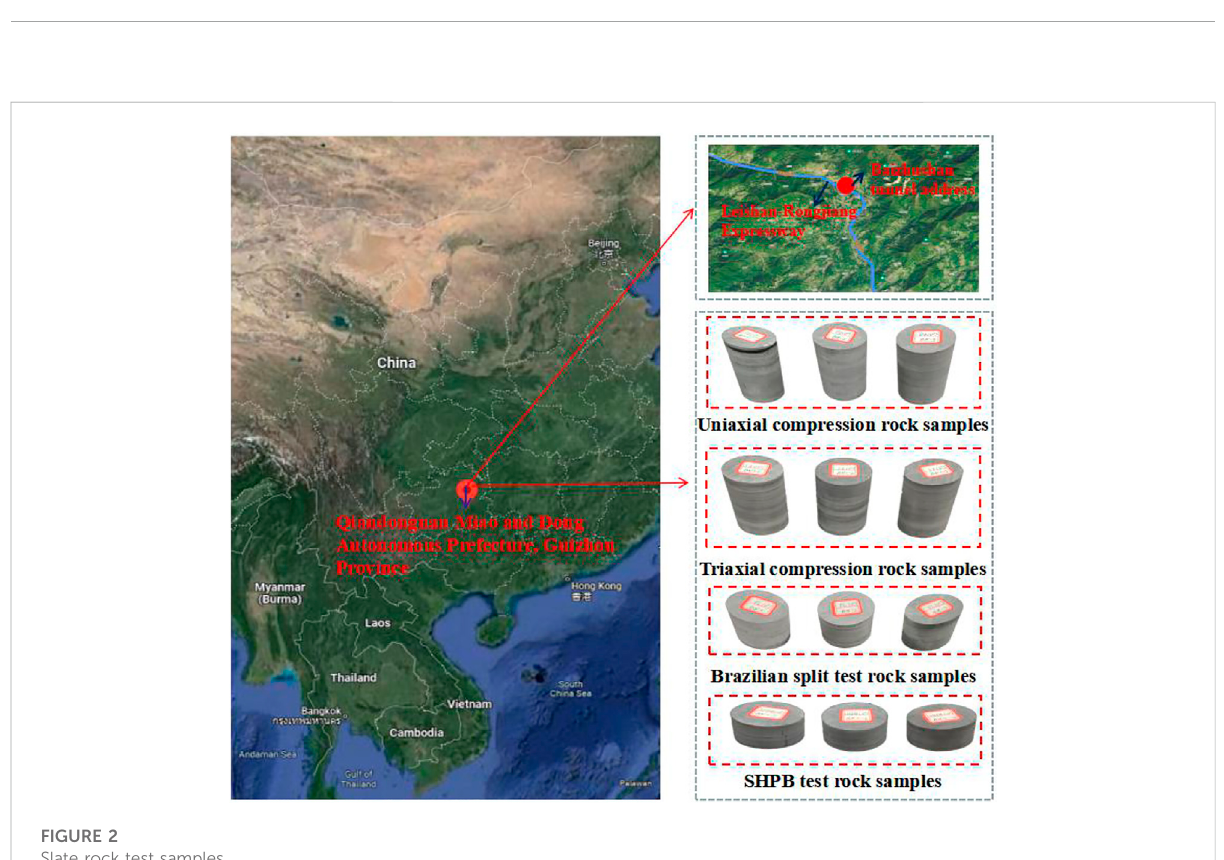
FIGURE 2 Slate rock test